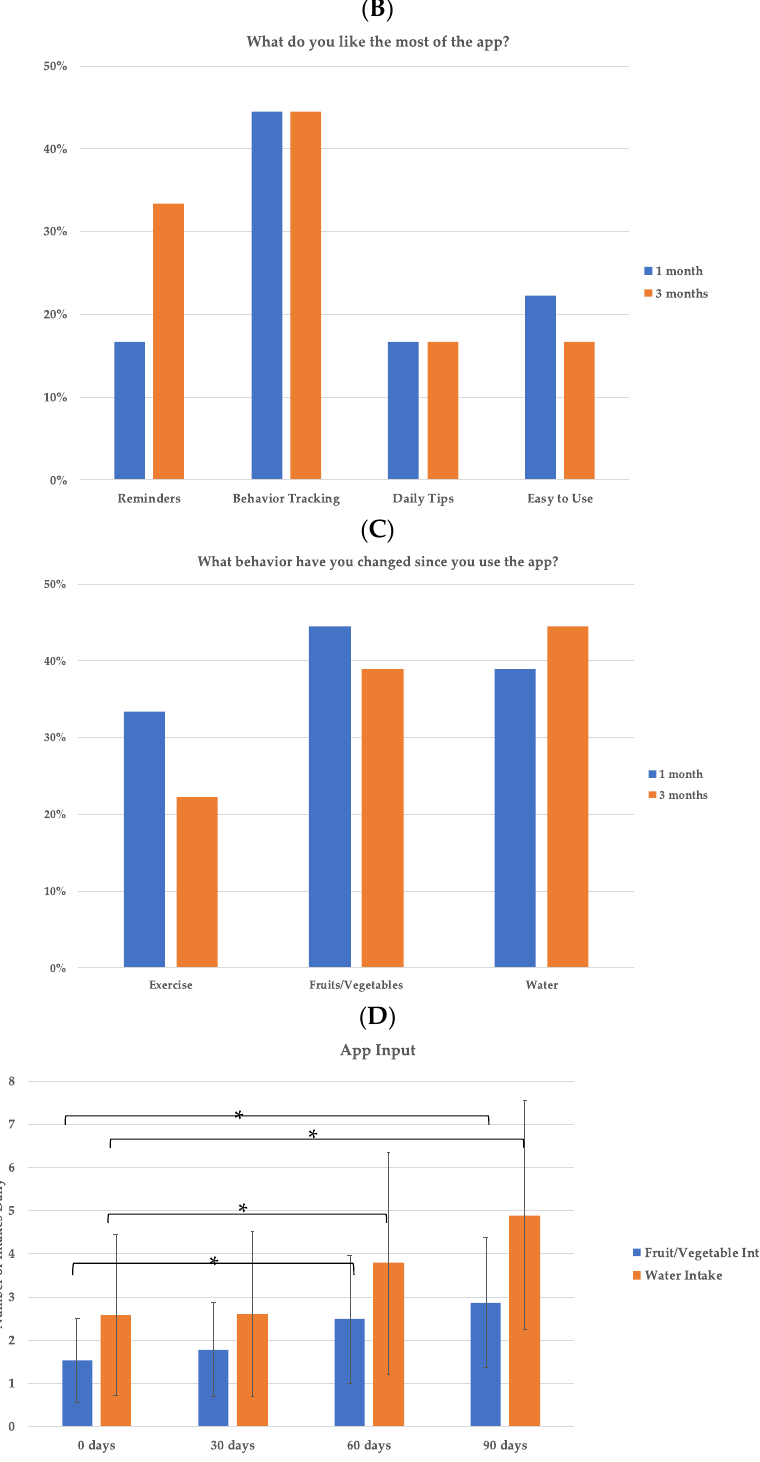
Figure 7. Results of the questionnaire regarding app usage in MTBApp group. ( A ) Results of questions regarding the usefulness of the app, based on a score of 0 (worse) to 10 (best score). ( B ) Percentage of users reporting what aspect did they like the most of the app. ( C ) Percentage of users reporting the behavior that they felt improved the most when using the app. ( D ) Input of the number of fruits/vegetables and water intake during the study. * p < 0.001.